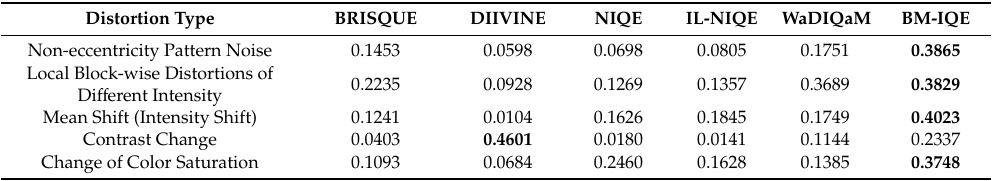
Table 7. Overall SROCC values of NR-IQA algorithms on particular distortion types of TID2013 database.